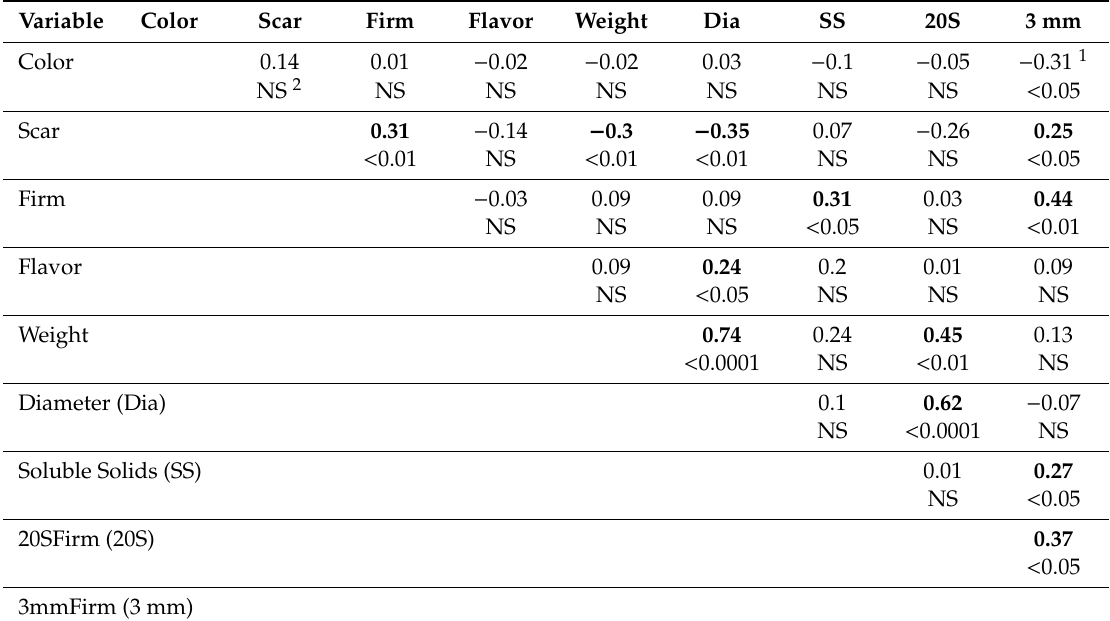
Table 3. Spearman correlation coe ffi cients among the fruit quality